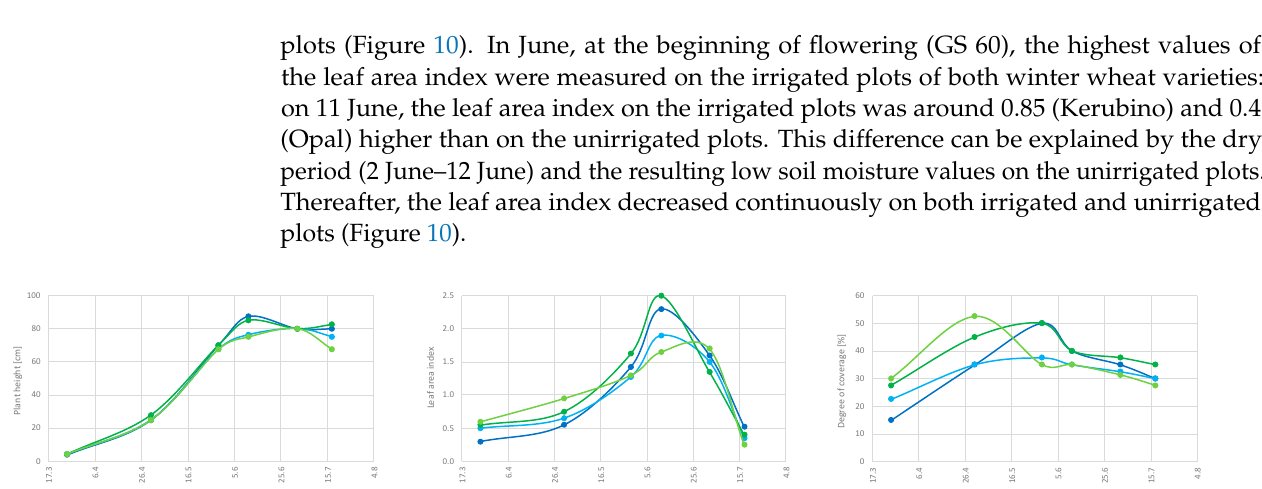
Figure 10. Measurements of the biometric parameters of the winter wheat varieties Opal and Kerubino on irrigated and unirrigated plots from March to July 2015; ( a ) plant height; ( b ) leaf area index; ( c ) degree of coverage.